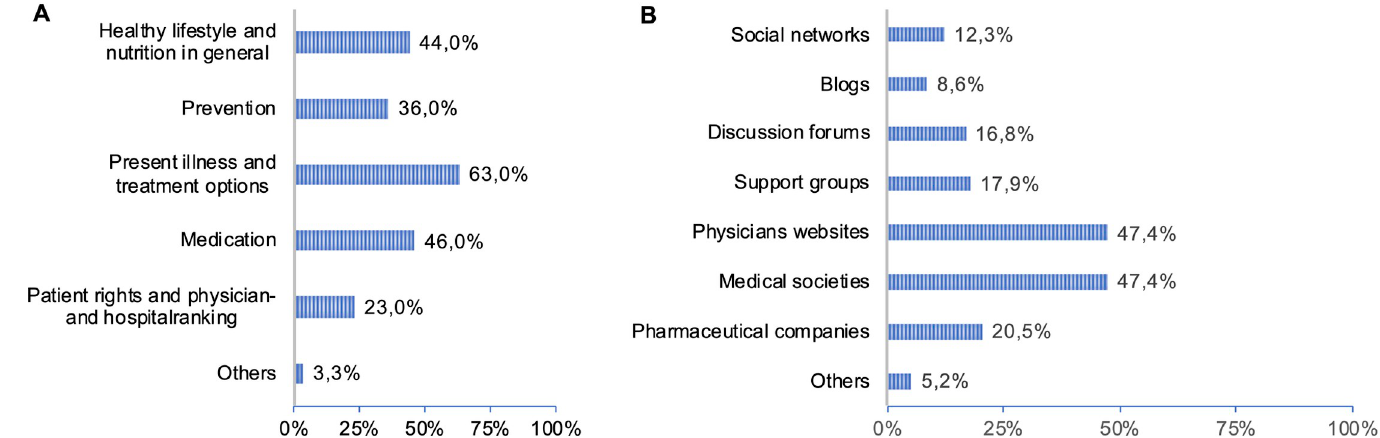
Fig 3. A. Online health-related information search. B. Sources of online health information.